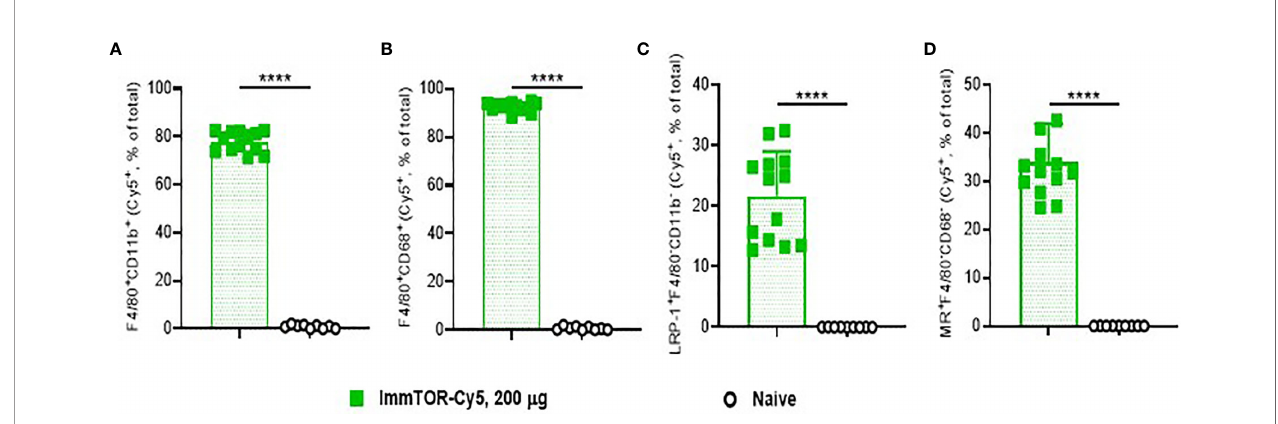
FIGURE 1 | ImmTOR traf fi cs to major liver cell populations after intravenous inoculation. Cy5-labeled ImmTOR particles (200 µg) were administered into the venous circulation via the retro-orbital venous sinus. Livers were harvested at day 7 and processed to single-cell suspensions, which were stained with antibodies to markers indicated and analyzed by fl ow cytometry. Fractions of Cy5-positive cytokine-producing (A) and phagocytic (B) Kupffer cells (F4/80 + CD11b + and F4/80 + CD68 + , respectively) as well as of hepatocytes (C) (LRP-1 + F4/80 – CD11b – ) and LSEC (D) (MR + F4/80 – CD68 – ) are shown (% of total). Summaries of three independent experiments in which identical time-points were assessed are shown (n = 9-13 mice/group). Background fl uorescence in naïve mice is also shown. Statistical difference in the size Cy5-positive fractions vs. that in naïve mice is shown (**** – p<0.0001; Mann-Whitney